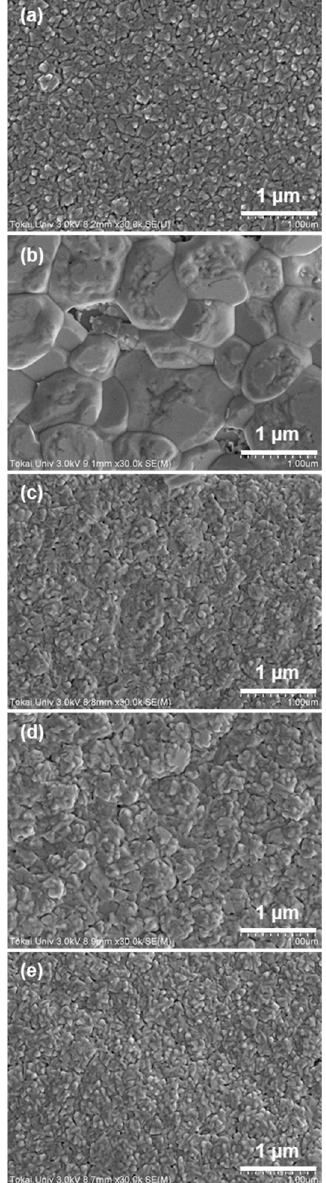
Figure 1. SEM images of the surface configurations of the Bi 2 Te 3 thin films ( a ) without heat treatment, and heat treatment at a temperature increase rate of ( b ) 4 K/min, ( c ) 8 K/min, ( d ) 12 K/min, and ( e ) 16 K/min.